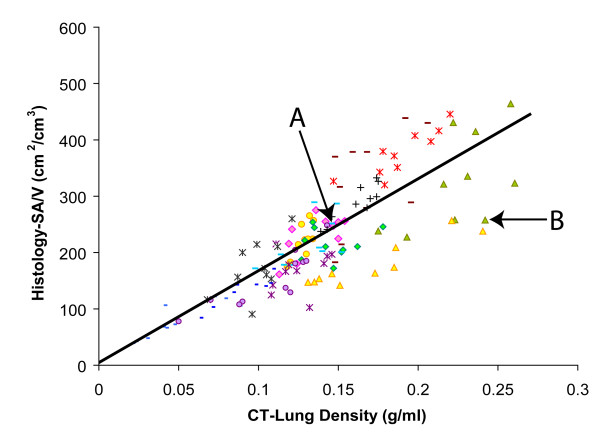
Association between the Histological SA/V and CT Median Lung Density. There is a significant association between the SA/V (cm2/cm3) measured histologically and the CT median lung density (g/ml) (r = 0.82, p < 0.0001). All subjects are shown using different symbols. Data point A and B refer to samples with comparable SA/V value but very different CT density measurement (sample A: SA/V = 247 cm2/cm3, CT density = 0.14 g/ml; sample B: SA/V = 258 cm2/cm3, CT density = 0.24 g/ml). A and B refer to the same samples in Figure 2, 3, and 5.